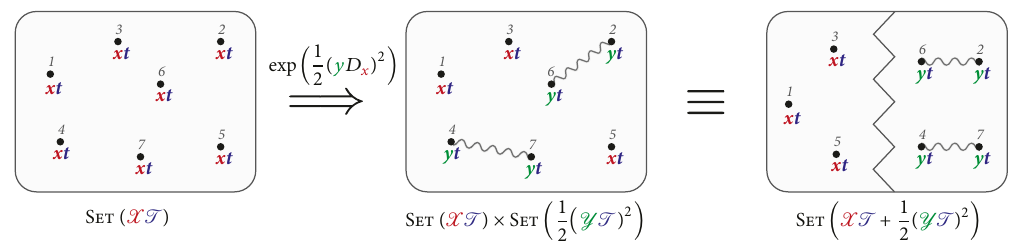
Figure1:Ontheleft,thereisaninstanceofastructureinclass F = Set ( XT ) ,i.e.,asetoflabelledatoms T whichareadditionallyweightedby an atom of type X . In the middle, example of a structure arising from the action of exp ((1/2)(𝑦𝐷 𝑥 ) 2 ) on F which is obtained by selecting a set ofdubletonsof X atomsandreplacingthembyatomsoftype Y .Selectedpairsaredepictedbywavylines.Ontheright,decompositionofsuch a structure into a product of two sets comprising, respectively, singletons XT (untouched by the derivatives) and doubletons (1/2)( YT ) 2 (selected by the